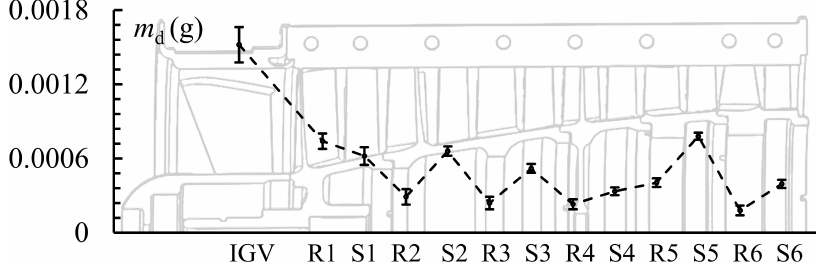
Figure 7. Mass deposited on a single airfoil for each row of the compressor unit. Table 2. Airfoil number and overview of the mass deposited on the single airfoil, row, and stage.